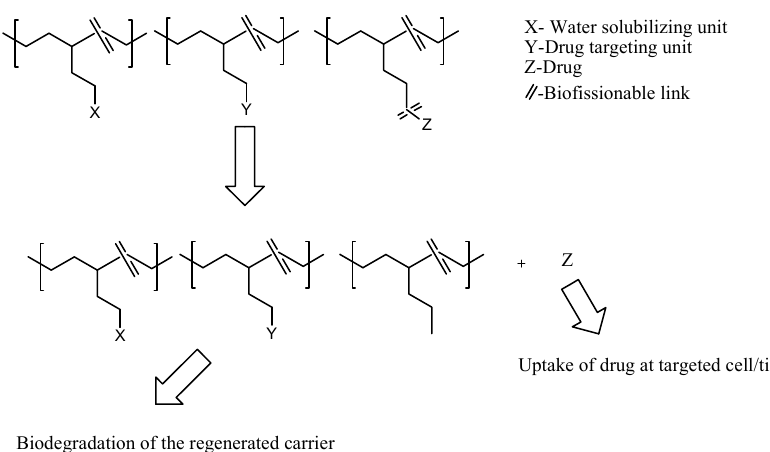
Figure 3. EPR (enhanced permeation retention) uptake of polymer-drug conjugates.